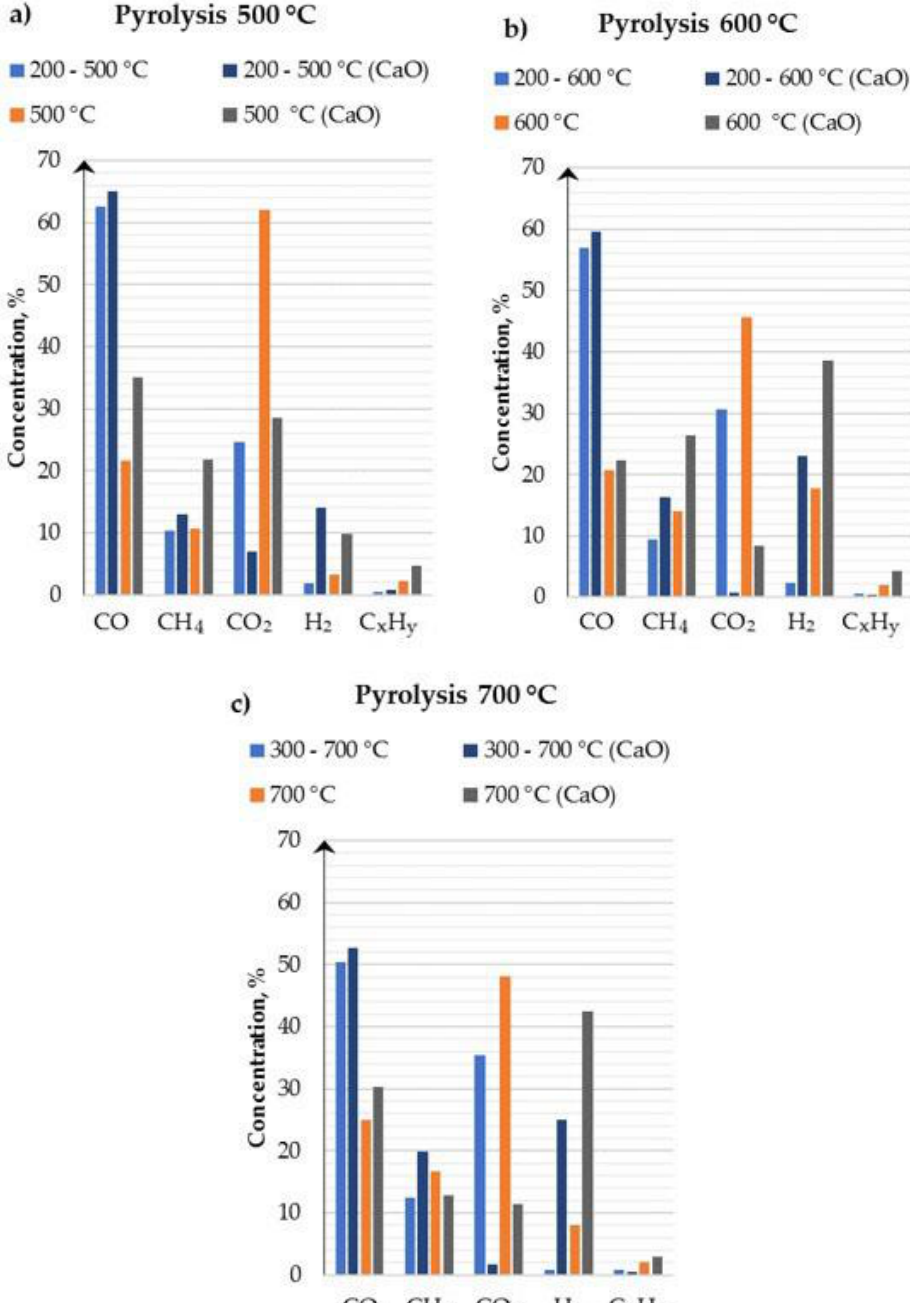
Figure 14. Syngas composition from the pyrolysis process at temperatures of (a) 500 °C, (b) 600 °C and (c) 700